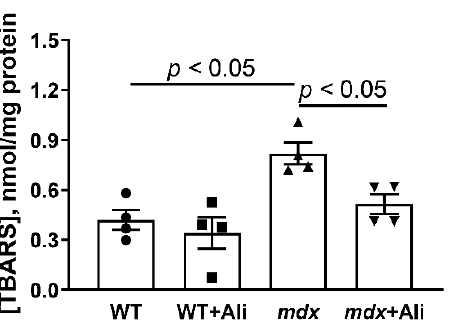
Figure 7. The effect of alisporivir on the content of the proteins of mitochondrial respiratory chain complexes. Data of Western blot analysis ( A ). The letter “M” indicates a positive control (rat heart tissue lysate; mitochondrial extract). Quantification of complex I/tubulin ratio ( B ), complex II/tubulin ratio ( C ), complex III/tubulin ratio ( D ), complex IV/tubulin ratio ( E ), and complex V/tubulin ratio (ATP synthase) ( F ). The data are presented as means ± SEM ( n = 6).